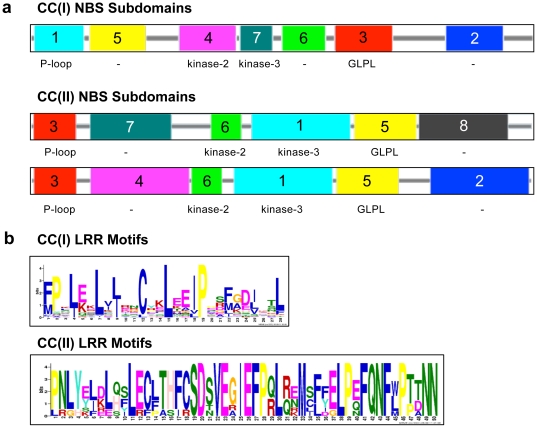
MEME analysis of NBS and LRR regions between CC(I) and CC(II) proteins.(a) NBS domain analysis. Different color boxes represent different subdomains. CC(I) and CC(II) were analyzed separately. Even though CC(II) has two different configurations, (subdomains 7-4 and 8-2) they are clustered together due to strong similarities on principal subdomains (P-loop, kinases and GLPL. Figure S5). (b) Predominant LRR motifs are also different between these two groups; CC(I) proteins have smaller and more abundant LRR. Different color letters represent amino acid belonging to different families.